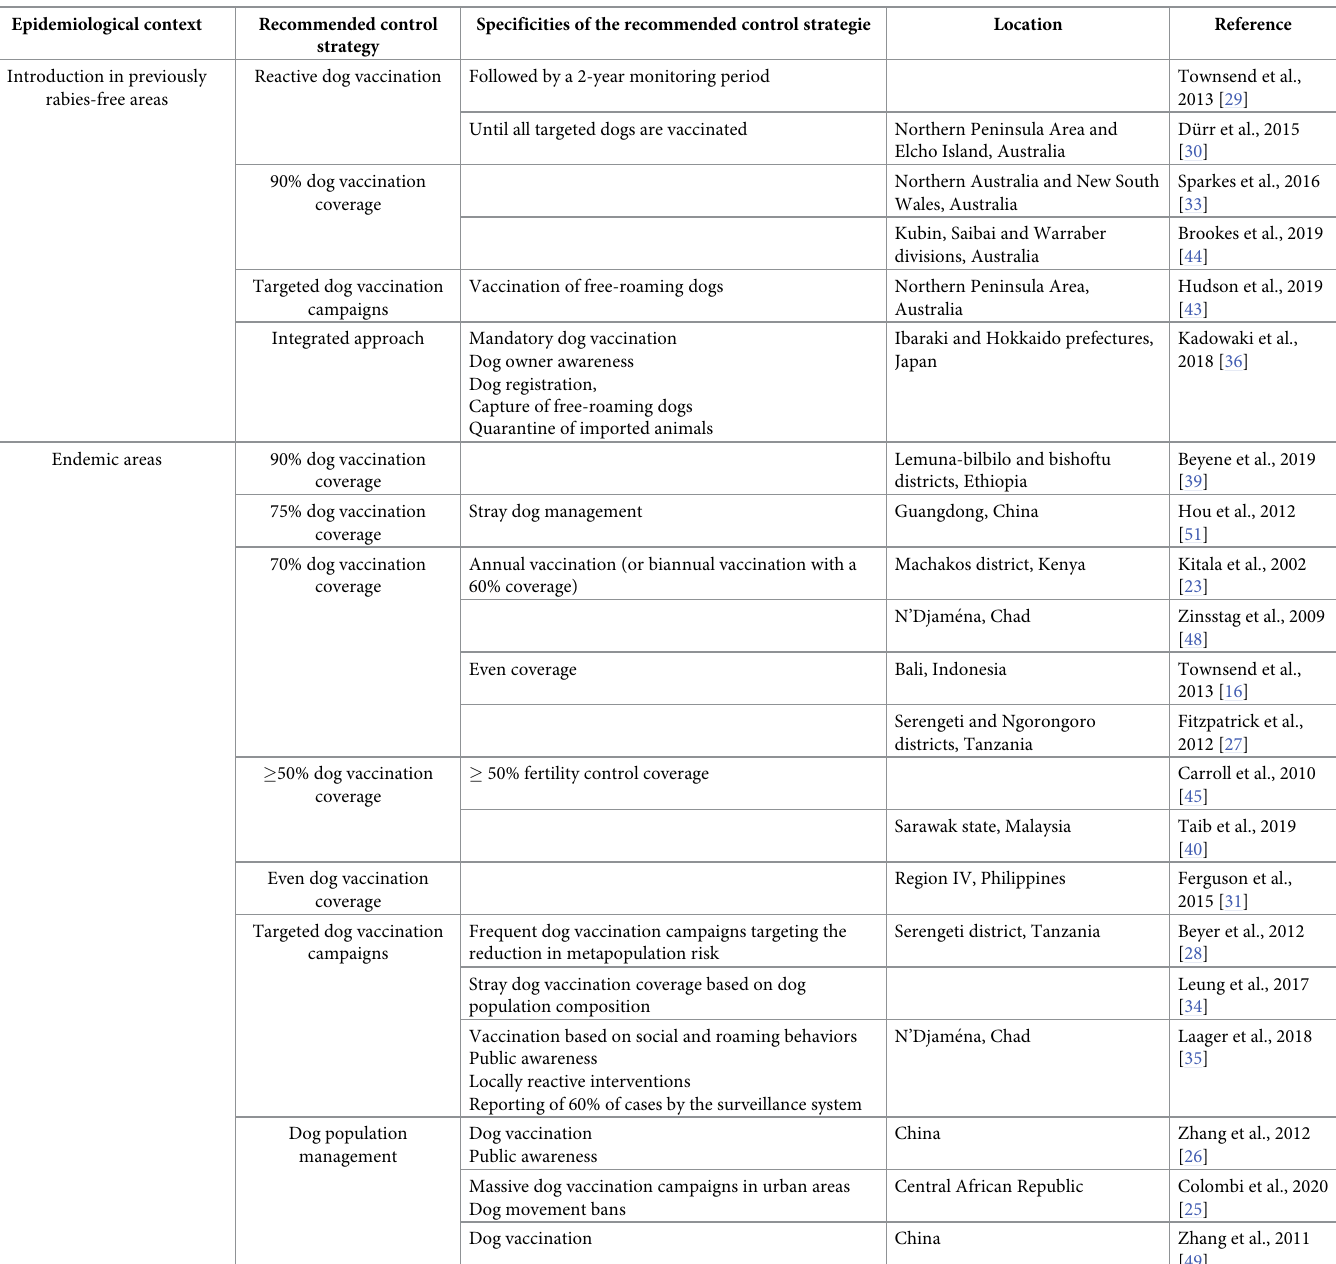
Table 2. Recommended control strategies in mathematical modelling